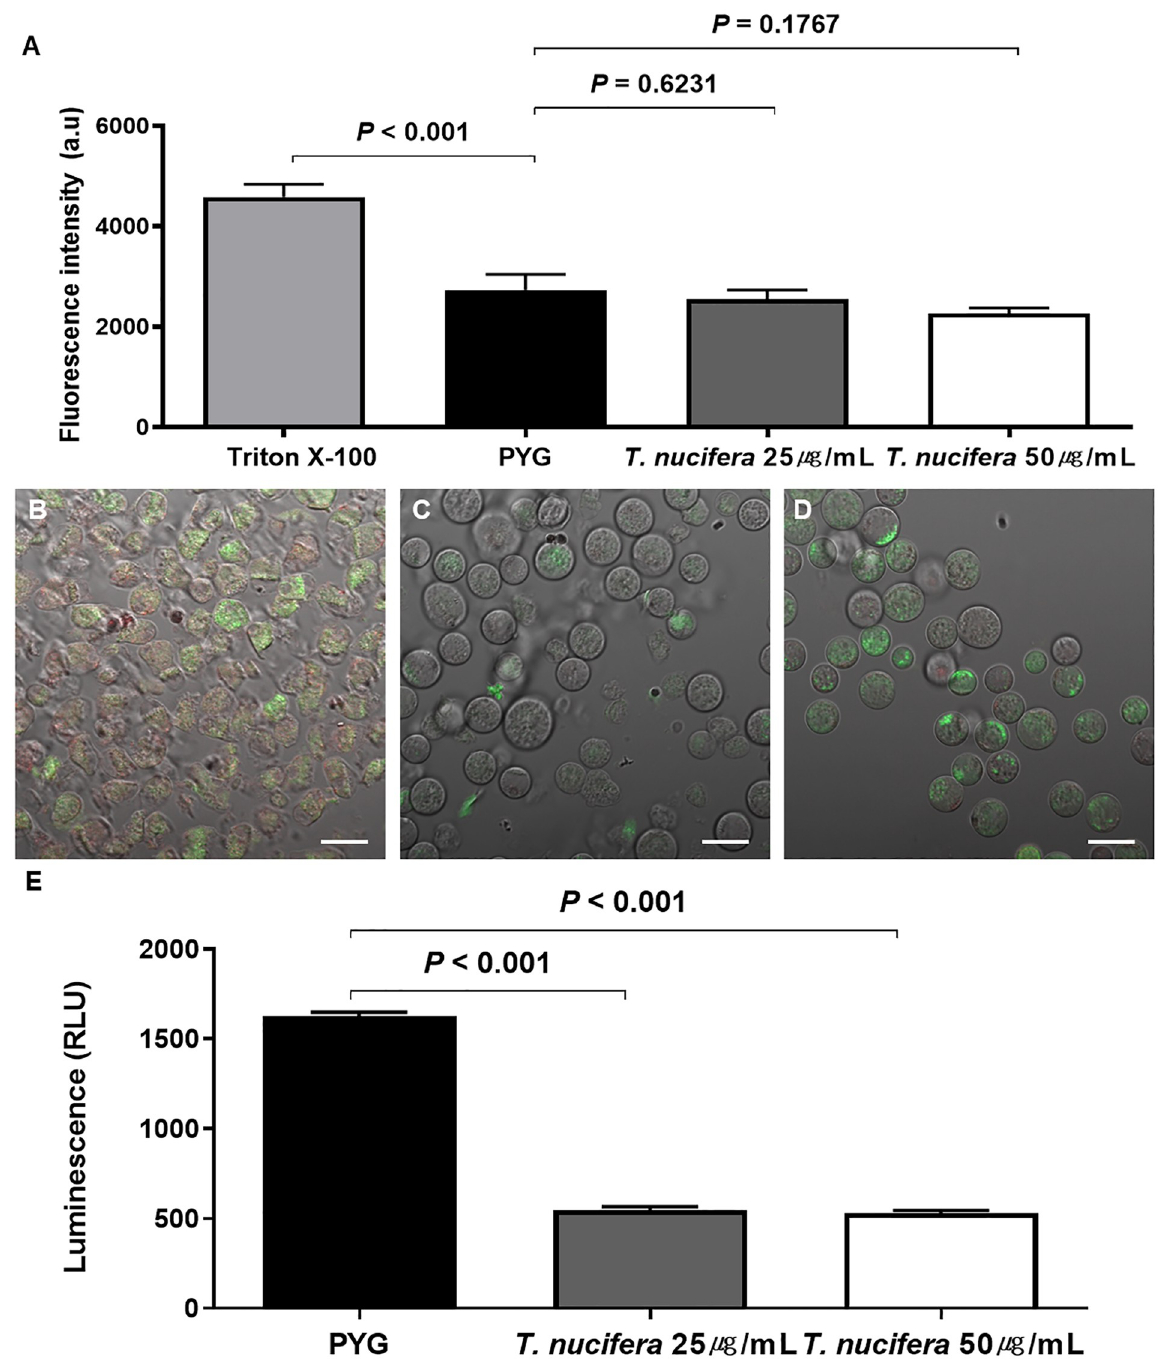
Fig 3. Cell membrane Permeability changes, mitochondrial membrane potential changes, and the effect of Torreya nucifera on ATP production in A . lugdunensis . Unlike the positive control group (Triton X-100), which showed high fluorescence, the groups treated with 25 μ g/ mL and 50 μ g/mL of T . nucifera showed significantly low fluorescence similar to that seen in the negative control group (A). In the control group, the mitochondrial membrane potential gradient was normal (B). Groups treated with 25 μ g/mL (C) and 50 μ g/mL (D) of T . nucifera showed the collapse of the mitochondrial membrane potential gradient indicated by the green fluorescence in the cytoplasm. The scale bar represents 20 μ m. ATP production showed that the luminescence amount was significantly reduced in the groups treated with 25 μ g/mL and 50 μ g/mL of T . nucifera compared to that in the control group